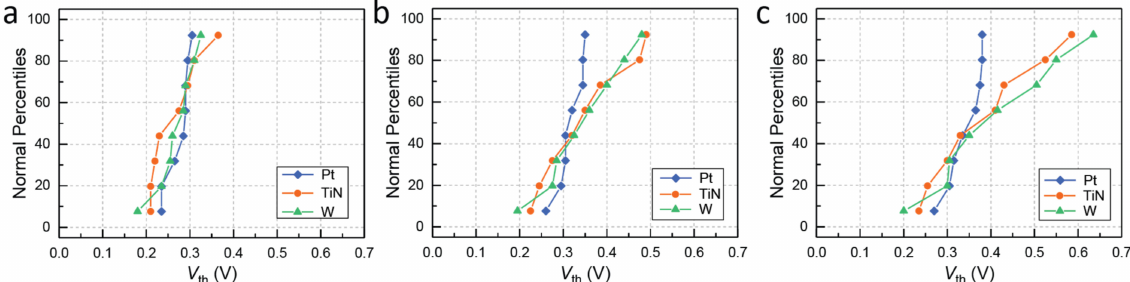
Figure 5. Distribution of the device-to-device variations in the threshold voltage ( V th ) for the three counter-electrode devices at the ( a ) 50th percentile (mean), ( b ) 90th percentile, and ( c ) 97th percentile.